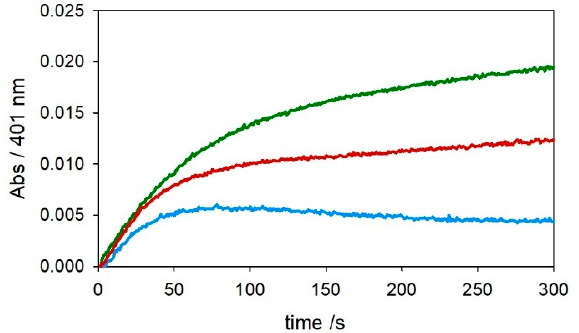
Figure 5. Kinetic profiles of MC (3 mM) oxidation with time in 50 mM HEPES buffer at pH 7.4 and 20 °C in the presence of Cu II alone (25 µM, green trace). The same experiments were also per- formed upon the addition of [Cu–A β 4–16 ] at 1:1 molar ratio (25 µM, light blue) and [Ni–Cu–A β 4–16 ] at 1:1:1 molar ratio (25 µM,